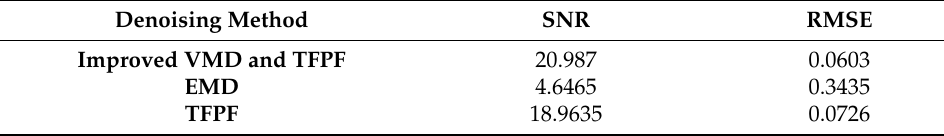
Figure 18. The spectrum of different denoising signals. Table 3. The denoising performance of different denoising Table 3. The parameter list of the constructed signal.